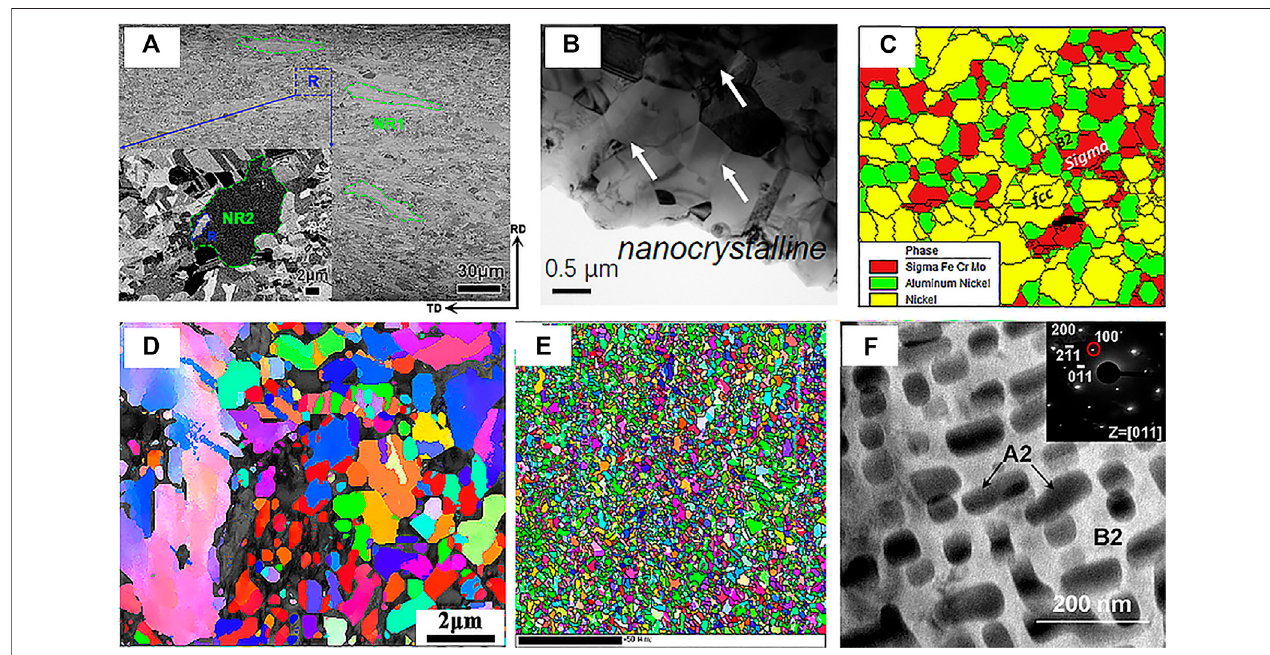
FIGURE 4 | Example microstructures of Al x CoCrFeNi HEAs under different conditions (A) BSE image of the 873 K-annealed Al 0.1 CoCrFeNi HEA, showing the microstructurecomposedofthreetypesofgrains:stretchedoriginalgrains,partiallyrecrystallizedgrainsoflargesize,andcompletelyrecrystallizedgrainsof fi nesize(Wu et al., 2019). (B) Nanocrystalline Al 0.25 CoCrFeNi HEA generated by directly annealing after cold rolling (He et al., 2020). (C) Tri-phase Al 0.3 CoCrFeNi HEA consisting of fcc, B2 and σ phases (Gwalani et al., 2018). (D) Ultra fi ne-grained Al 0.45 CoCrFeNi HEA generated in the recrystallization area after annealing at 800 ° C (Hou et al., 2019). (E) Fully-recrystallized Al 0.5 CoCrFeNi HEA with re fi ned grains (Guo et al., 2018). (F) Cuboidal participates with the side length ranging from 20 to 180 nm, randomly distributed in the B2 matrix of Al 0.7 CoCrFeNi HEA (Shi et al.,